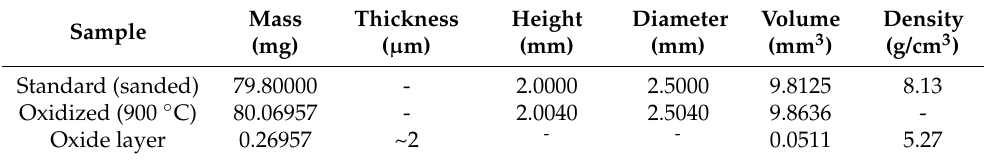
Table 3. Average dimensions and mass of the samples before and after the oxidation process at 900 ◦